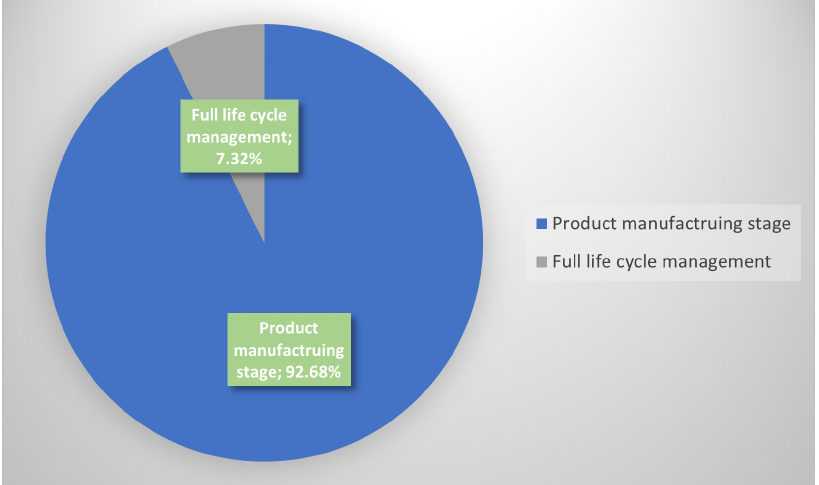
Figure 16. Contribution of ML-based DT in manufacturing product lifecycle management